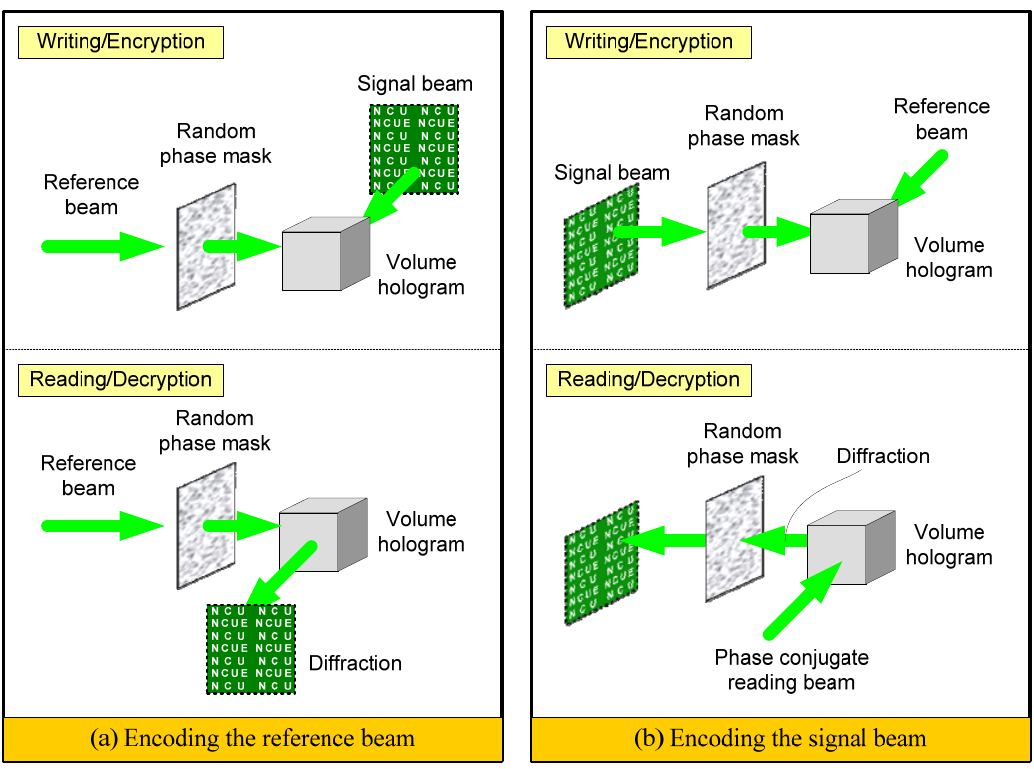
Figure 1. Two different schemes of encrypted holographic storage using random phase